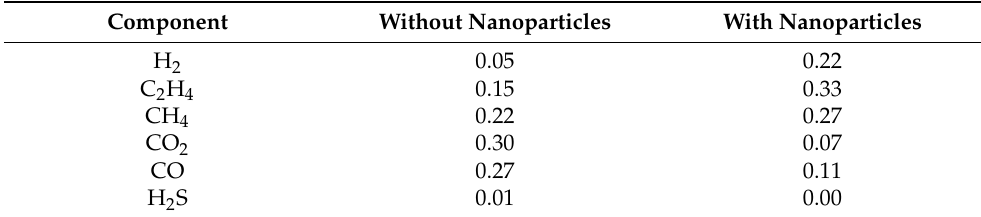
Table 1. Molar composition of the gas mixture released during steam injection test of HO1 during the first steam injection (without nanoparticles) and the steam injection after nanofluid soaking with porous medium (with